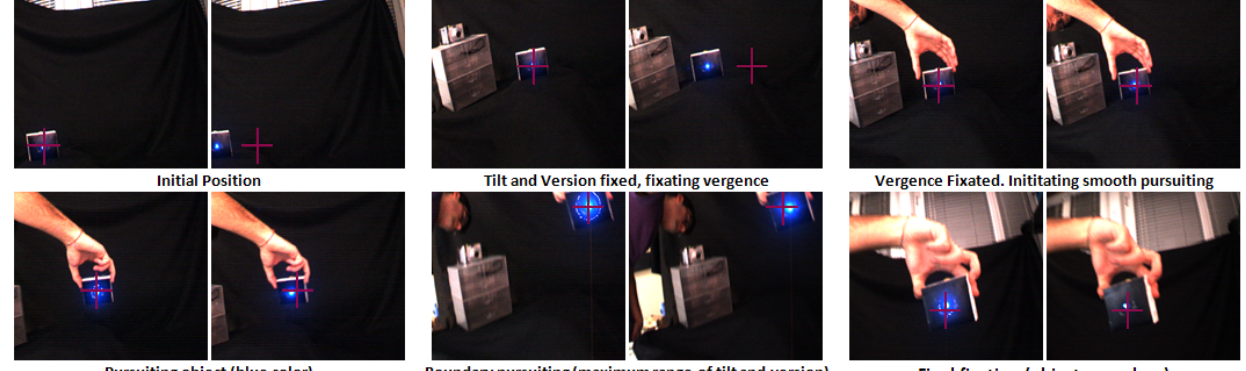
Figure 13. Blue LED smooth pursuit. At each different phase, we show the left and right images of our system, beginning with the fixation and then, with the pursuit of the target